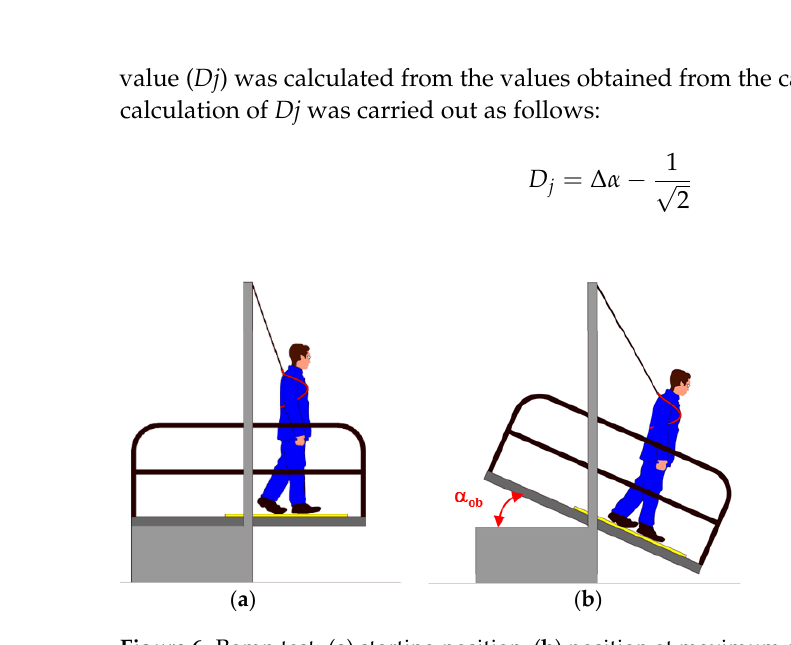
Figure 6. Ramp test: ( a ) starting position, ( b ) position at maximum acceptable angle  ob.